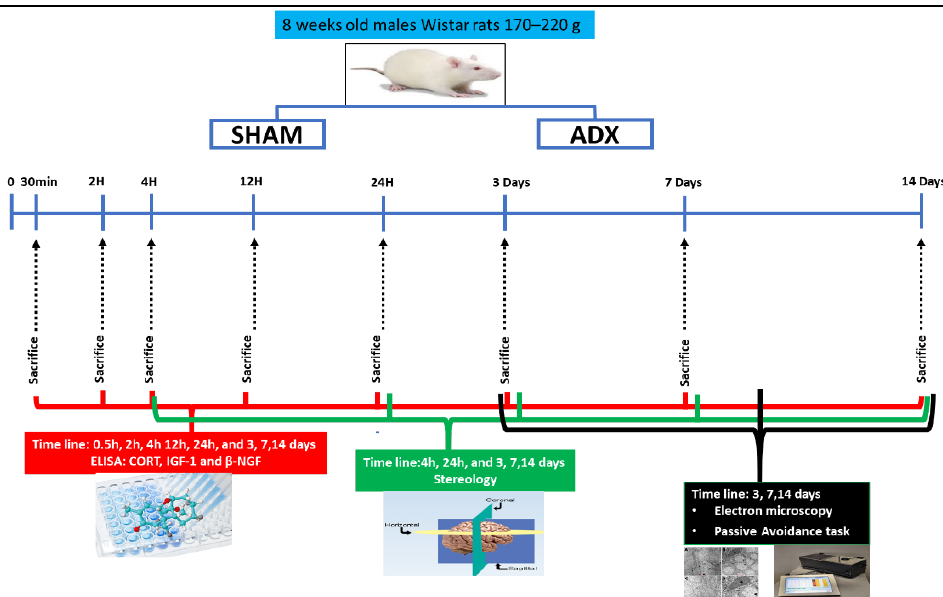
Figure 1. Schematic illustration of adrenalectomy (surgery), biochemical measurements of corticos- terone (CORT), insulin-like growth factor-1 (IGF-1) and β -nerve growth factor ( β -NGF), stereology cell counting, electron microscopy and Passive Avoidance task. The levels of corticosterone (CORT) in the serum were measured by Enzyme Immunoassay (EIA) to assess the efficacy of